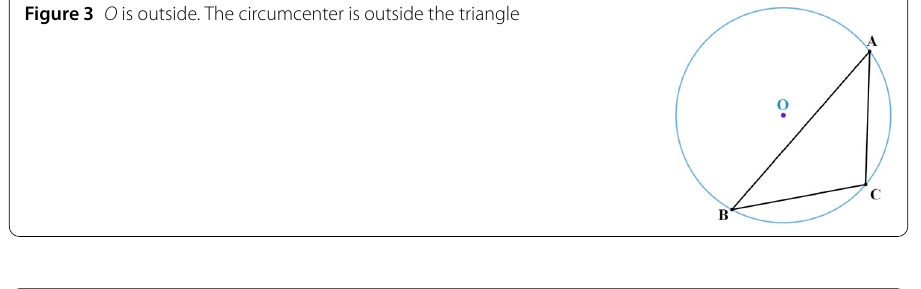
Figure 4 Auxiliary lines. Auxiliary lines when O is outside (cid:2)